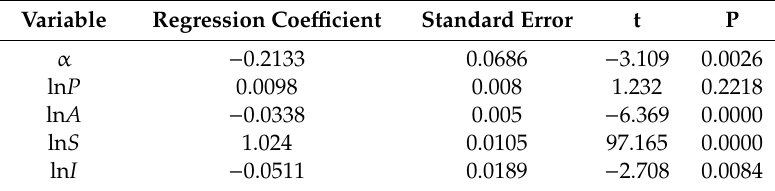
Table 5. STIRPAT (Stochastic Impacts by Regression on Population, A ffl uence, and Technology) model regression